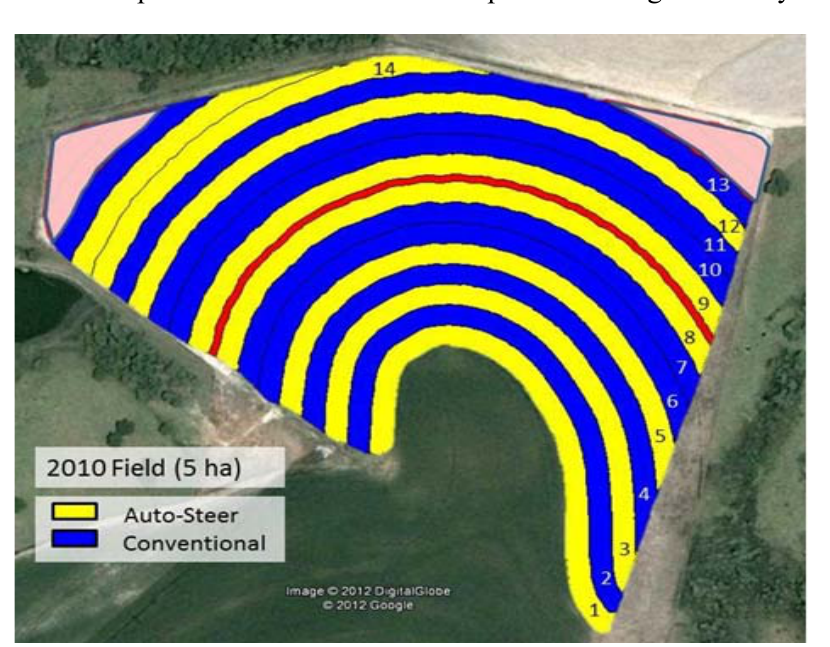
Figure 2. Experimental design used in 2010. Each replicate (colored strip) = 12 rows of peanuts or three 4-row passes. Numbers indicate strips used during data analysis.